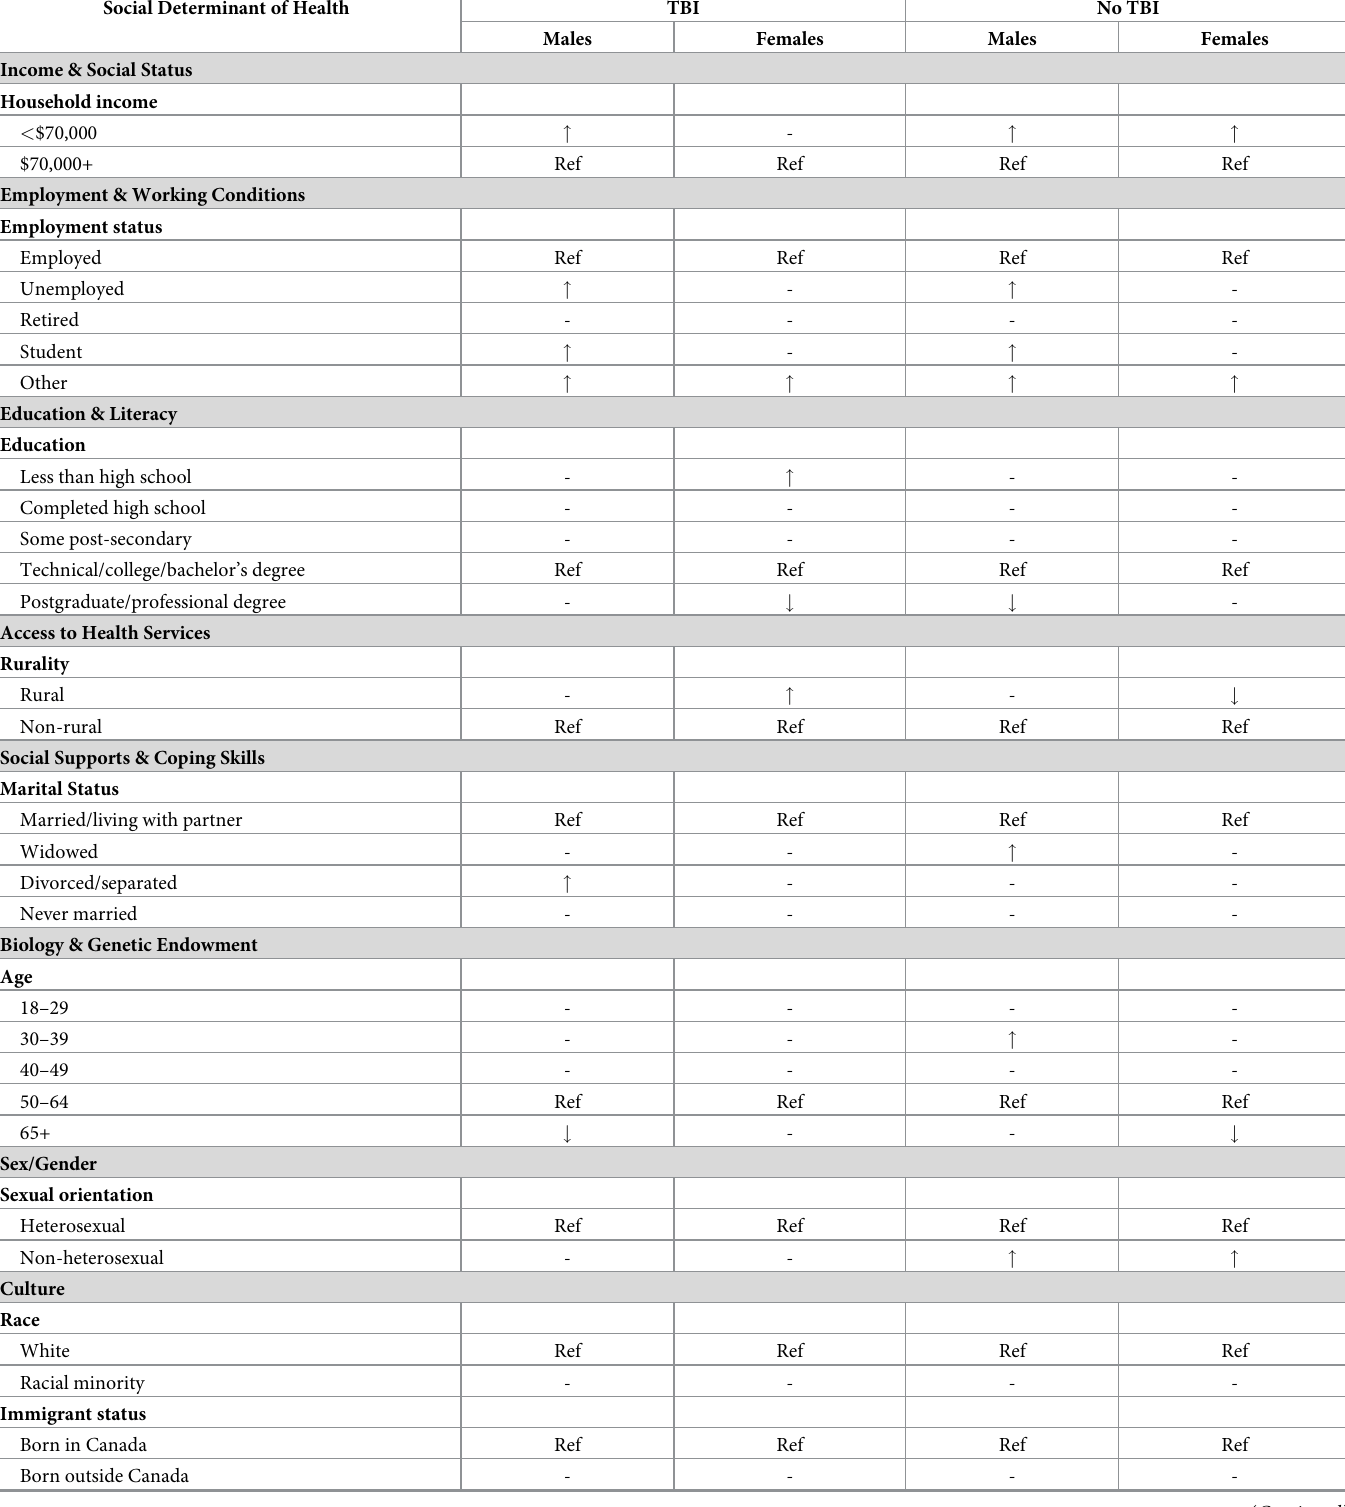
Table 1. Visual comparison of the SDoH associated with psychological distress, by sex and TBI status, from multivariable logistic regression models. Social Determinant of